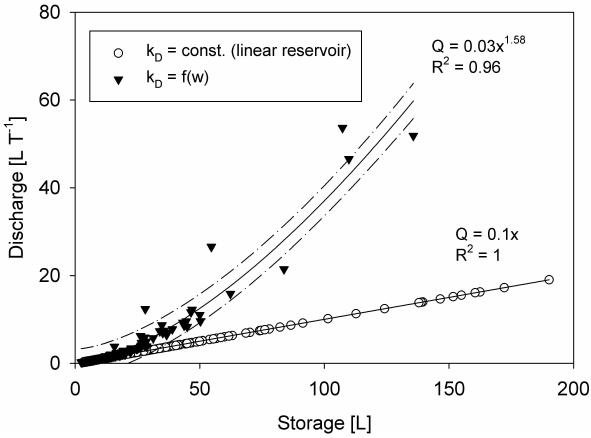
Fig. 5. Hypothetical example of storage – discharge relationships with synthetic constant k D , representing a linear reservoir and with k D as function of catchment wetness w . In this example k D was linearly related to synthetic 5-day antecedent precipitation totals.